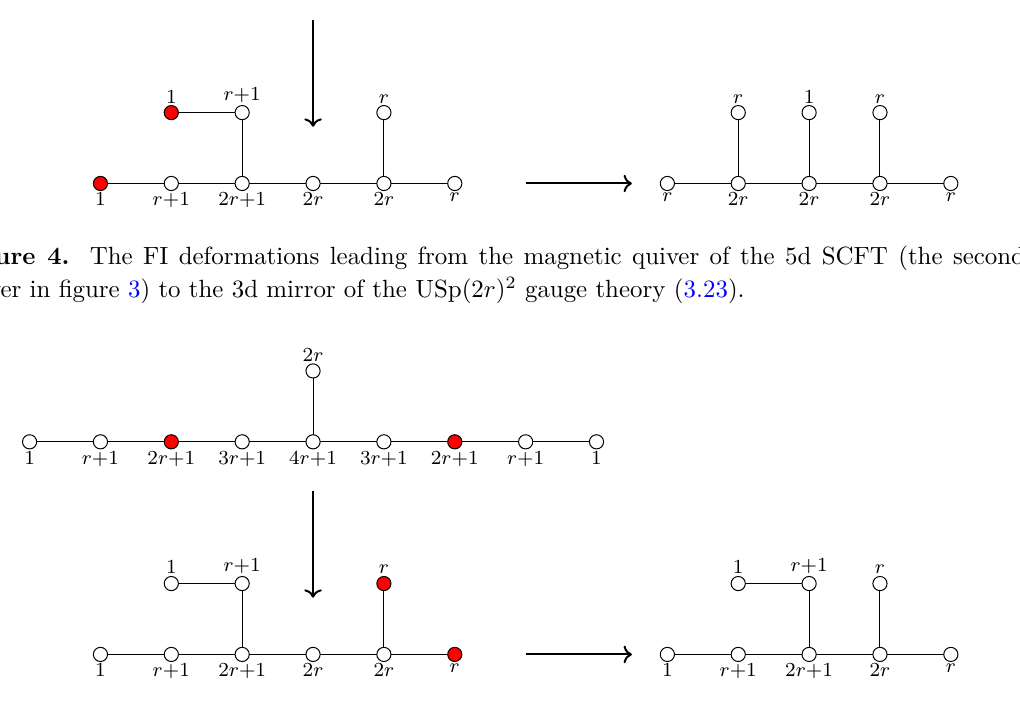
Figure 5. The FI deformations of the last quiver in figure 3 leading to the 3d mirror of the USp(2 r ) 2 gauge theory (3.24) with 2 flavors on each